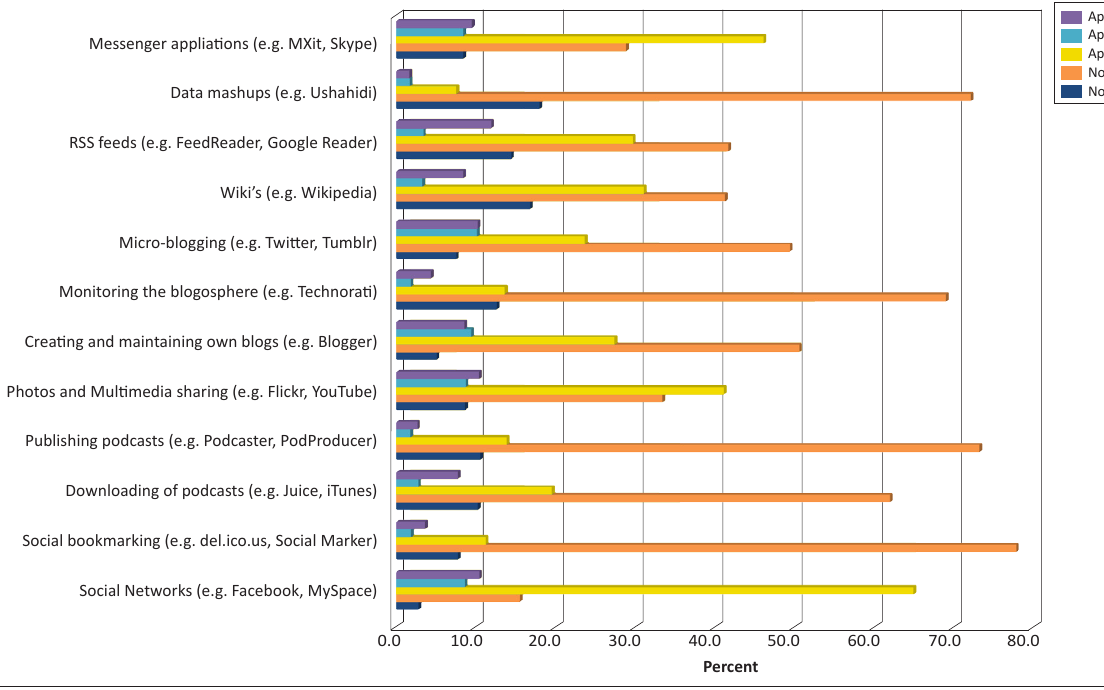
FIGURE 2: Social media service adoption in South African civil society